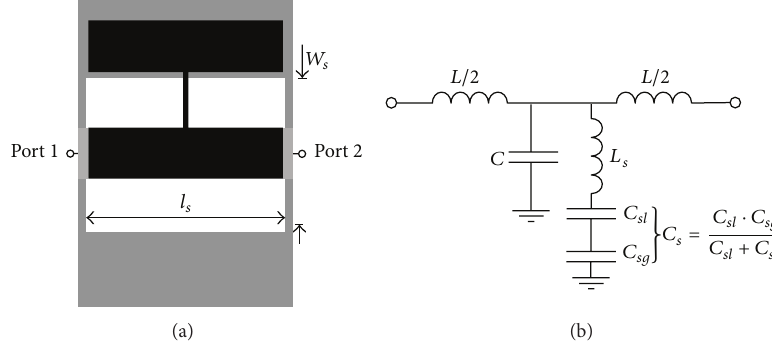
Figure 4: Proof of concept demonstrator of an SIR loaded microstrip line useful as alignment/position sensor for a displacement corresponding to the strongest notch (a) and lumped element equivalent circuit model (b). The microstrip line dimensions are 𝑊 = 2 mm, = 5.8 mm, and 𝑙 = 7.8 mm; the lengths of the SIR sections are 2mm, and the widths are 𝑤 𝑊 𝑠 𝑠 bottom substrates are Rogers RO3010 with ℎ = 0.254 mm, 𝜀 𝑟 = 11.2 , and tan 𝛿 = 0.0023 . The inductance and capacitance of the line section are 𝐿 and 𝐶 , the inductance of the SIR is 𝐿 𝑠 , the SIR-to-line capacitance is 𝐶 𝑠𝑙 , and the SIR-to-ground capacitance is 𝐶 𝑠𝑔